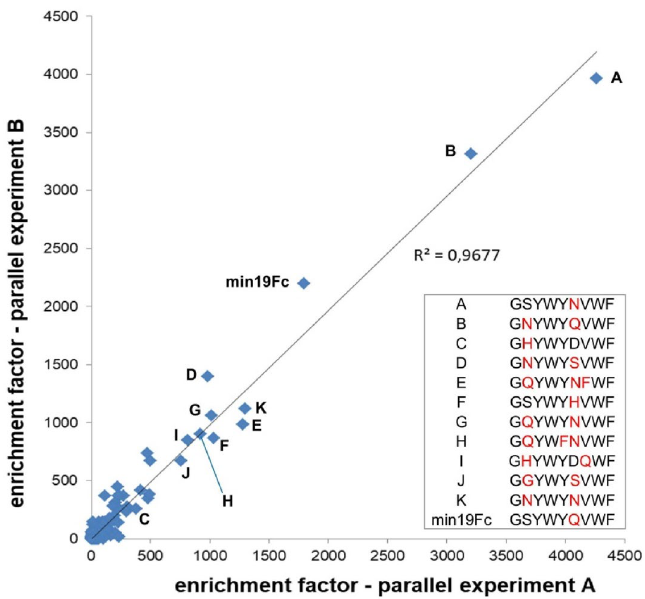
Figure 3. Correlation of enrichment factors for peptides eluted at pH 3.6 in 2 parallel experiments (N = 5090; each peptide detected at least once in at least one of the experiments). Peptide names are indicated in capital letters and their corresponding amino acid sequences are shown in the inset box. Residues differing from the parent peptide min19Fc-Q6D are shown in red.